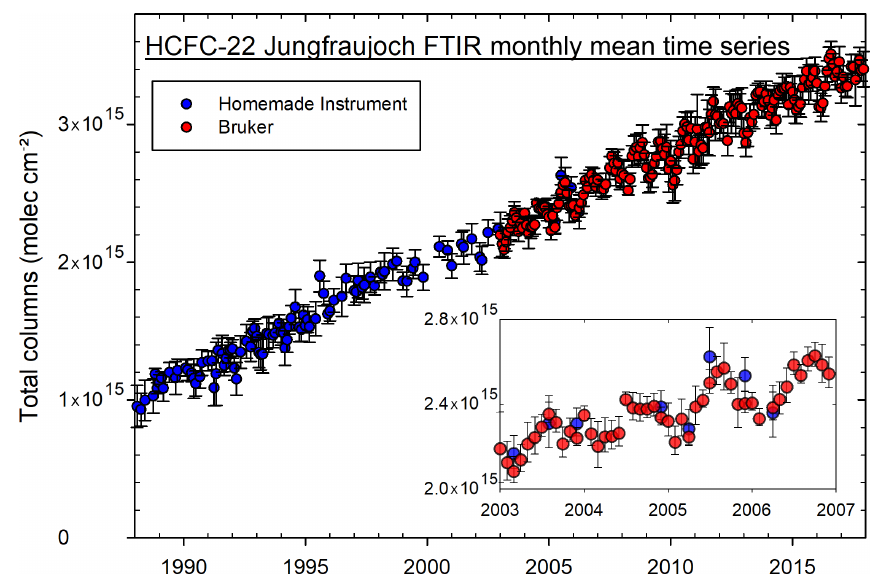
Figure 3. FTIR monthly time series of HCFC-22 total columns above Jungfraujoch derived from spectra recorded by the homemade FTIR (blue) as well as by the Bruker IFS 120HR (red). Vertical bars are the standard deviations around the monthly means. Due to pollution events starting in 1996 that mainly influenced the Bruker instrument, observations retrieved from the Bruker spectra are discarded before 2003. Note the excellent agreement between the two instruments (inset